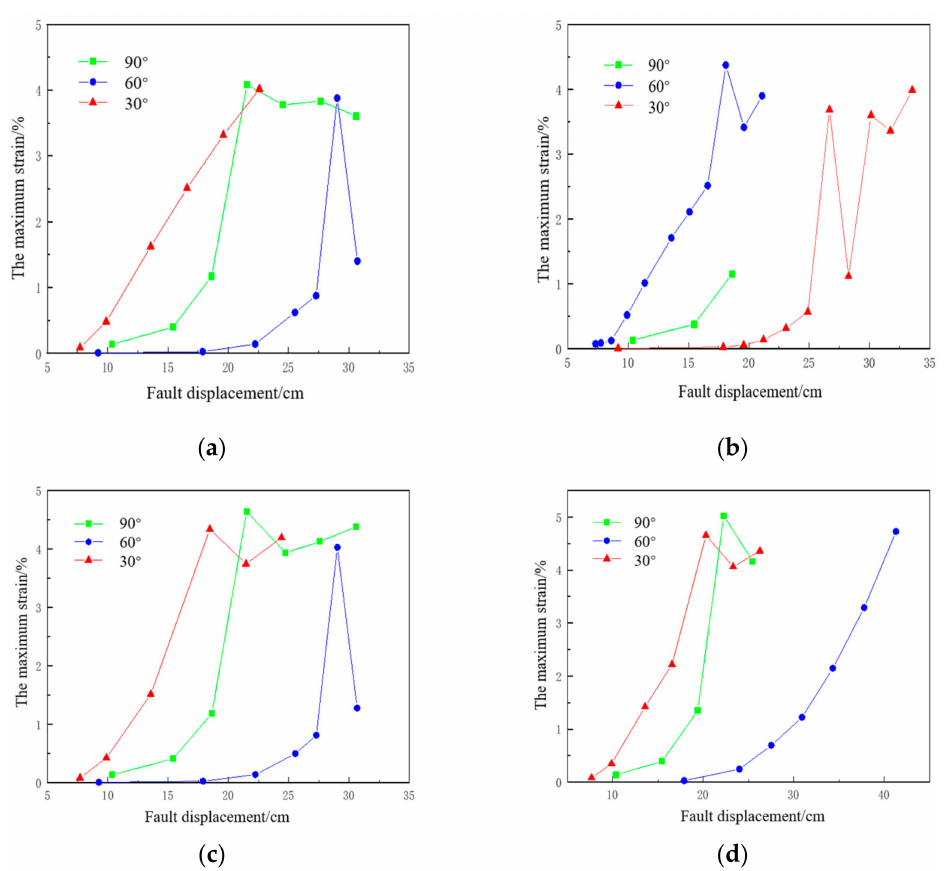
Figure 12. The maximum strain change law of pipeline under different included angles: ( a ) 323.9 × 7.1; ( b ) 323.9 × 7.5; ( c ) 329.9 × 8.0; ( d ) 329.9 ×